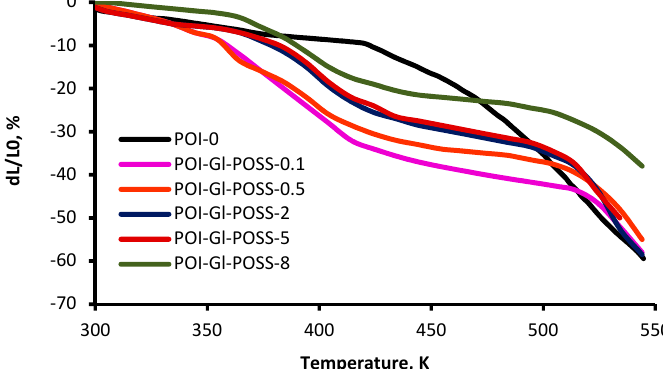
Figure 6. The curves of the thermomechanical analysis of POI-Gl-POSS.